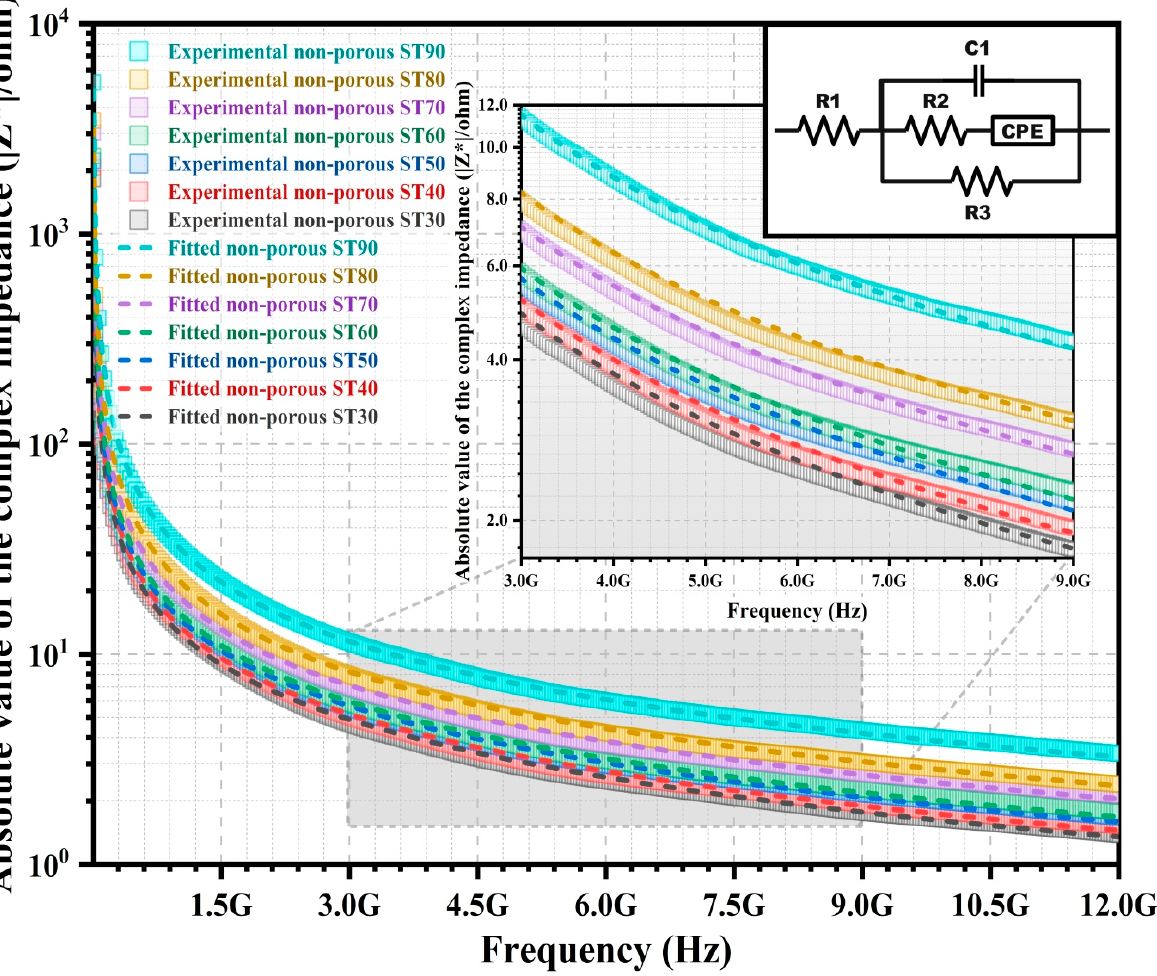
Figure 6. Impedance plot of non-porous HAp/ST composites with equivalent electrical circuit model (inset).